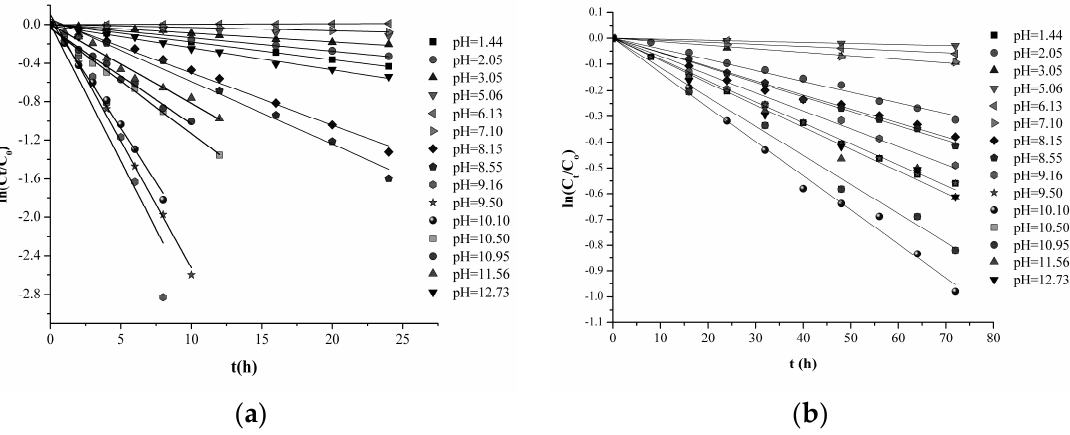
Figure 2. First-order plots for HSYA degradation at 25 °C in aqueous solution ( a ) and XBJ injection ( b ).